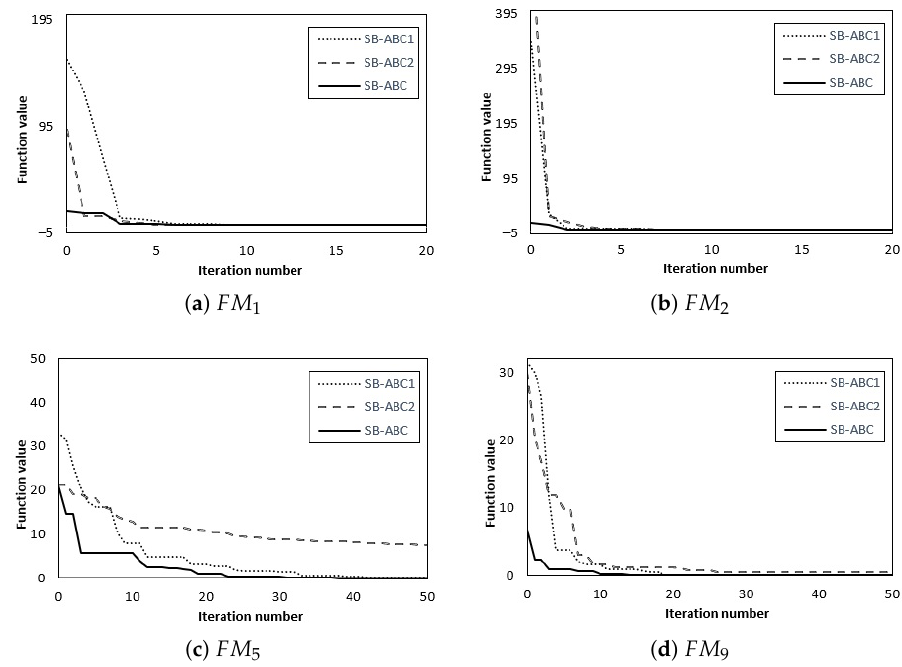
Figure 2. Convergence graphs of SB-ABC1, SB-ABC2 and SB-ABC for the selected minimax